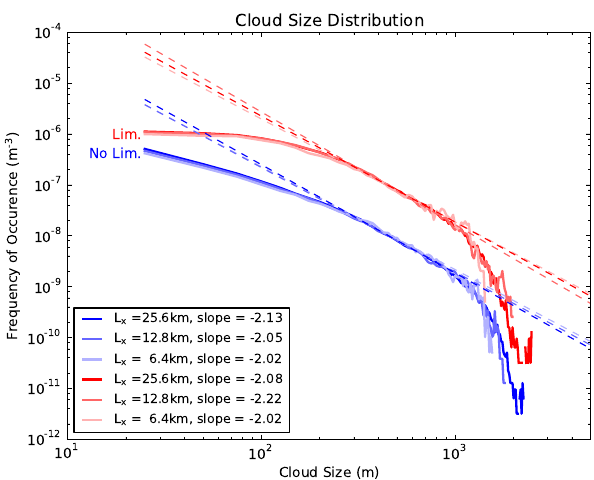
Fig. 15. Cloud size distribution as a function of domain size and the scalar advection scheme for hours 3–8 of RICO. Red colors: MUSCLE flux limiter scheme, multiplied by a factor 10 for visibil- ity. Blue colors: no limiter applied. Dashed lines denote the best fit power law between 400 and